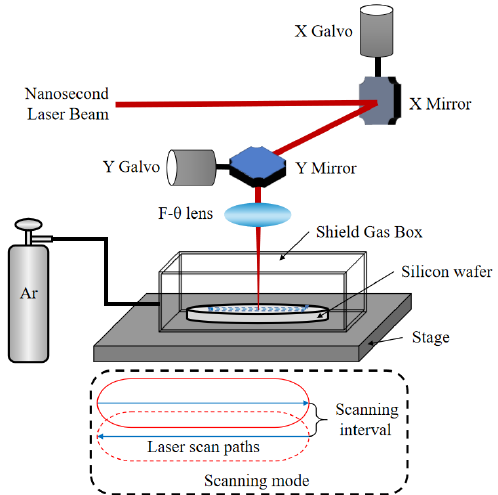
Figure 1. Schematic for experimental setup of laser grinding single-crystal silicon wafer.